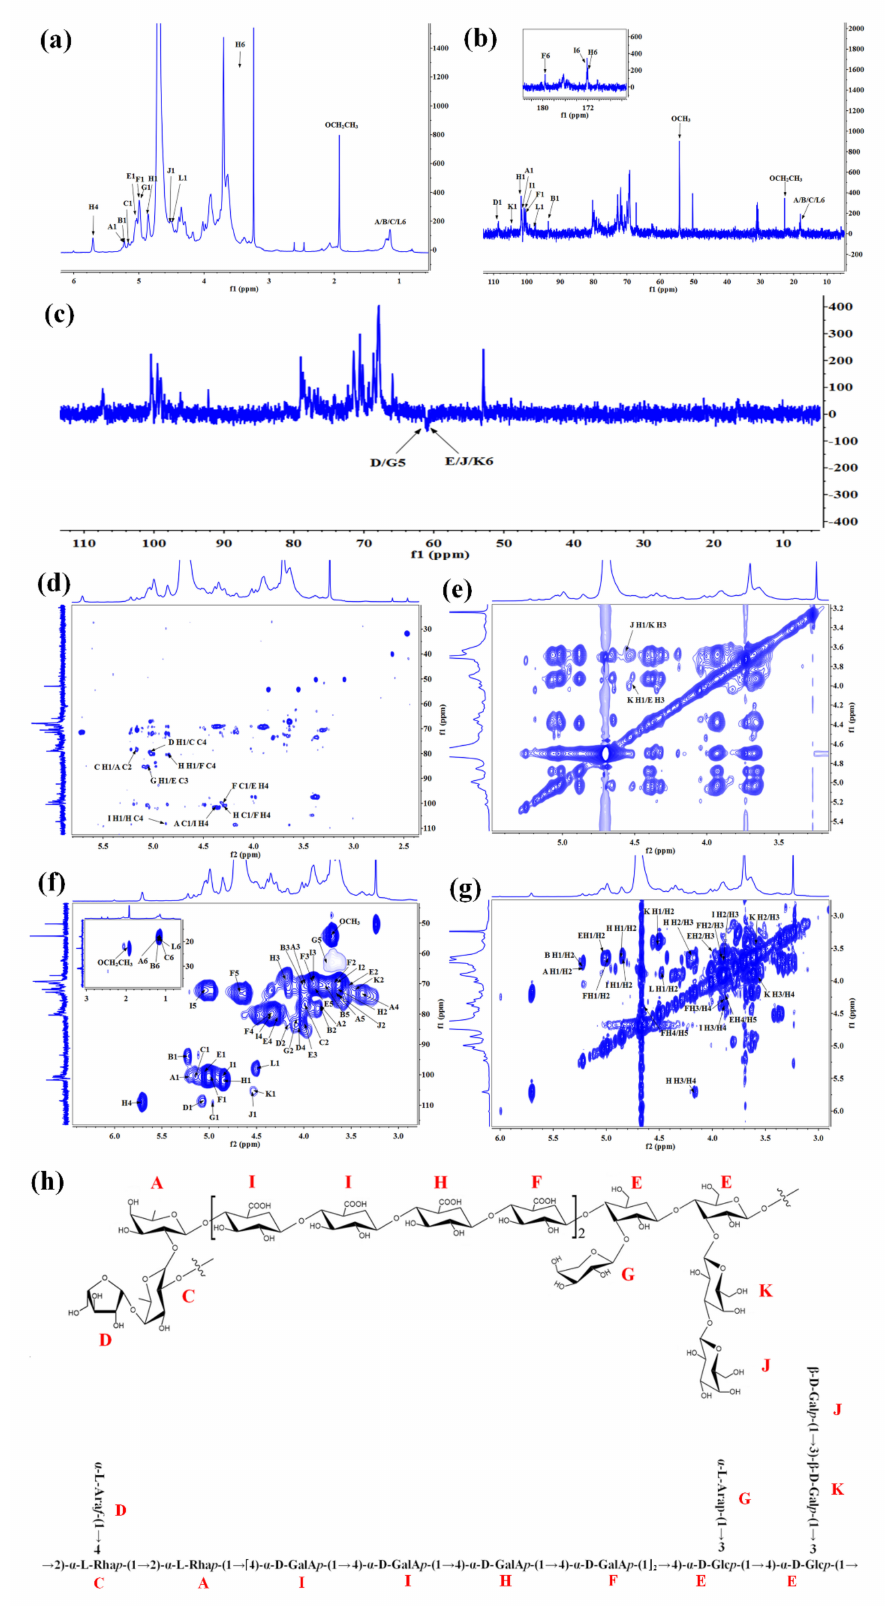
Figure 6. NMR spectra and the suggested structure of RPP-2a. ( a ) 1 H NMR. ( b ) 13 C NMR. ( c ) DEPT-135. ( d ) HMBC. ( e ) NOESY. ( f ) HSQC. ( g ) COSY. ( h ) The structure of